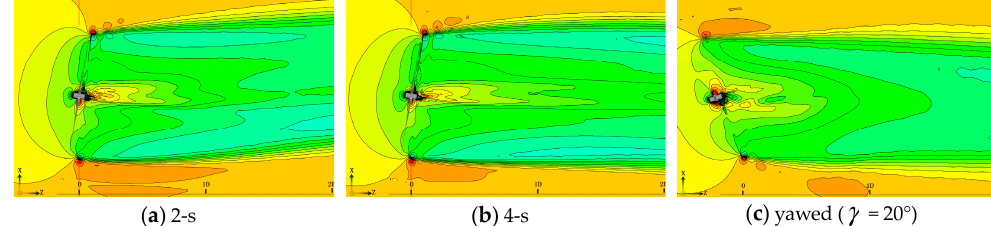
Figure 23. Velocity contours for Case 5.